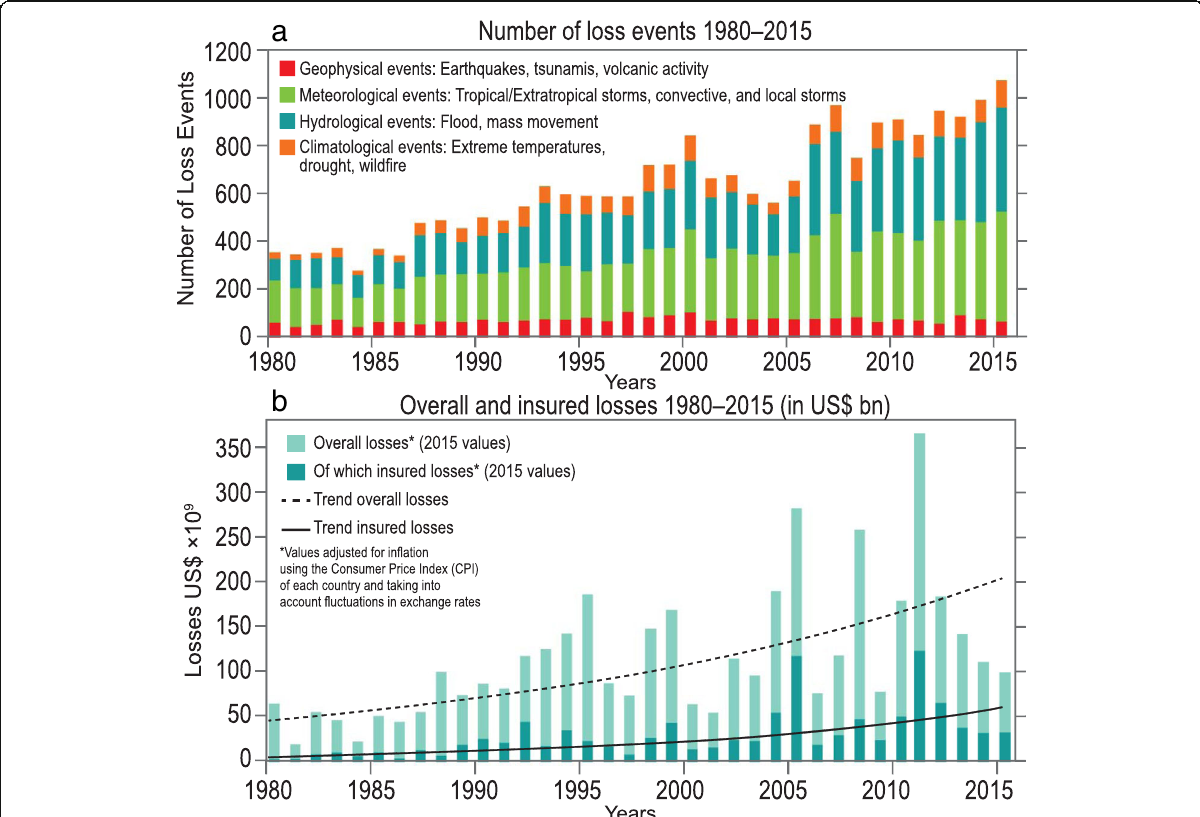
Fig. 18 The frequency ( a ) of and monetary losses ( b ) from the major natural and environmental disasters across the globe. Source: Munich Re-insurance NatCatSERVICE